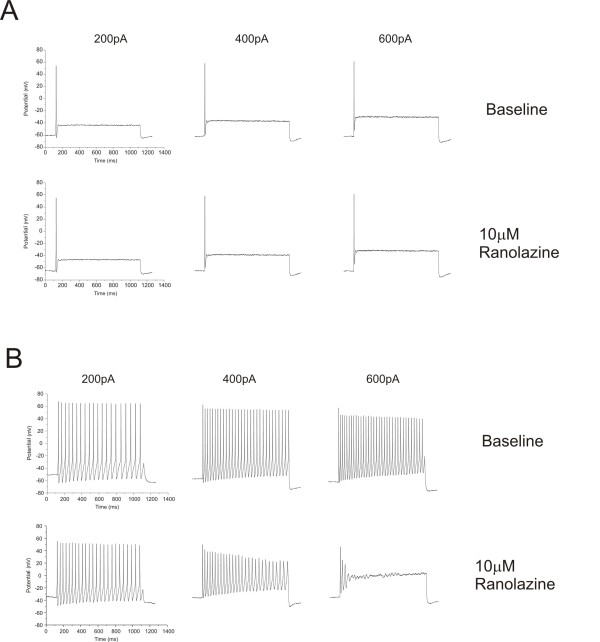
Example responses to ranolazine from WT-expressing DRG neurons. (A) Traces illustrating the response to 1 second duration current injections of 200pA, 400pA, and 600pA both before (upper row) and after (lower row) exposure to 10 μM ranolazine are shown from a DRG neuron transfected with hNav1.7-WT channels. This phenotype, showing low frequency firing, typically occurs in 5 of 6 WT-expressing DRG neurons chosen for recording. (B) Traces in the same format as panel A recorded from a high frequency firing WT-expressing DRG neuron.